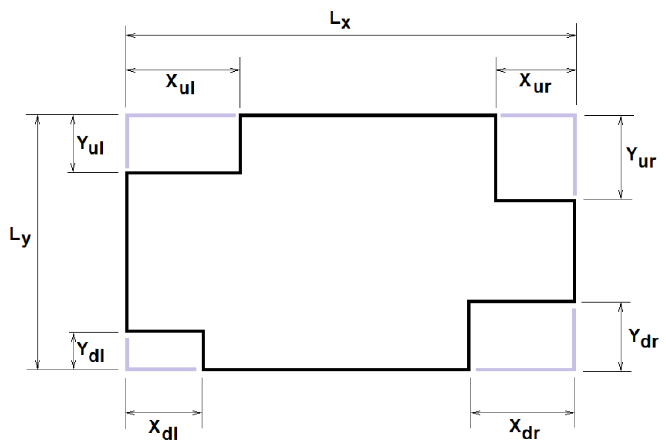
Figure 8. Generic way of describing the clipped vertex collector.